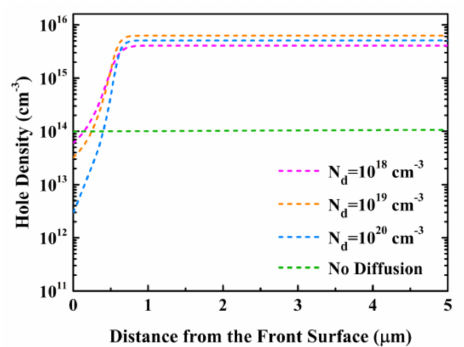
Figure 5. Variation in the hole density as a function of the distance from the front surface of the IBC solar cell model for di ff erent front surface layer doping concentrations. The FSRV is 2000 cm / s in all